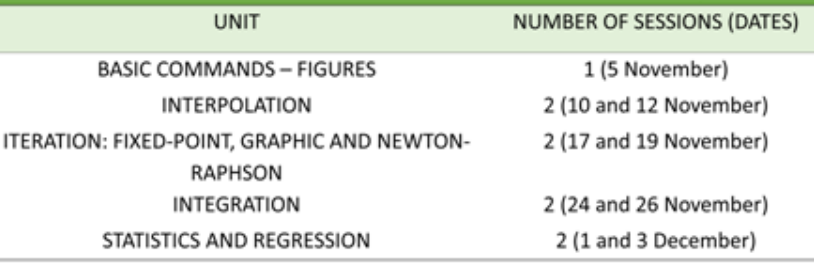
Figure 5. Temporal planning